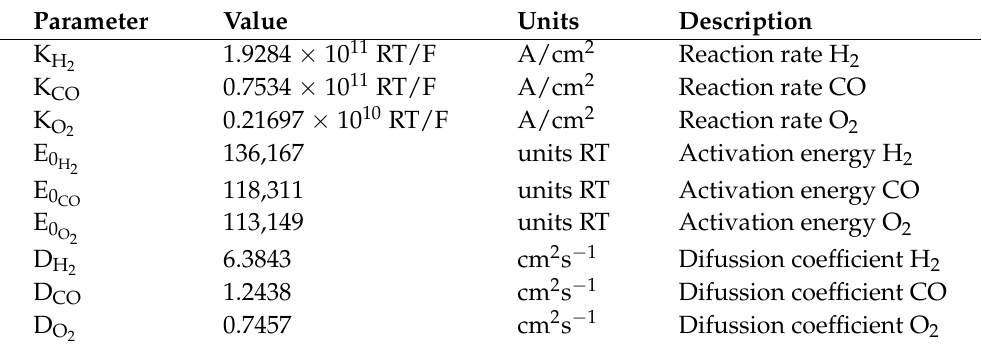
Table 2. List of model calibration parameters and their values.